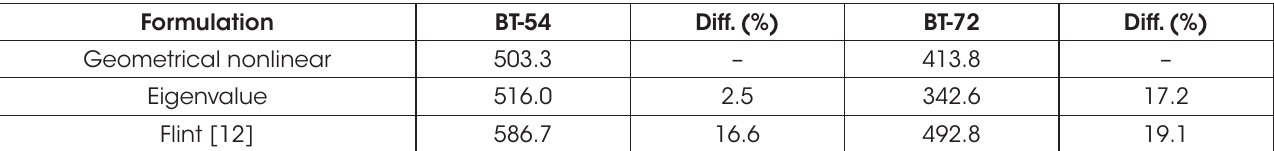
Comparison between numerical and analytical solutions of instability load